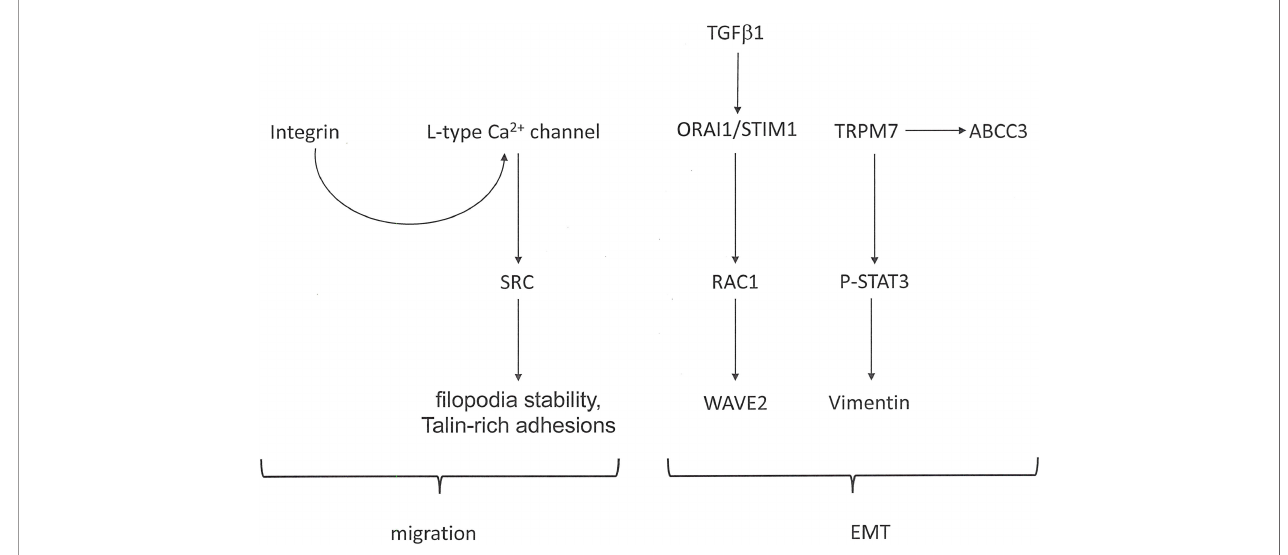
FIGURE 2 | Calcium signaling in cancer metastasis. In cancer progression, calcium fl ux is involved in facilitating cell migration as well as epithelial-mesenchymal transition (EMT). The Figure shows pathways that are activated in these